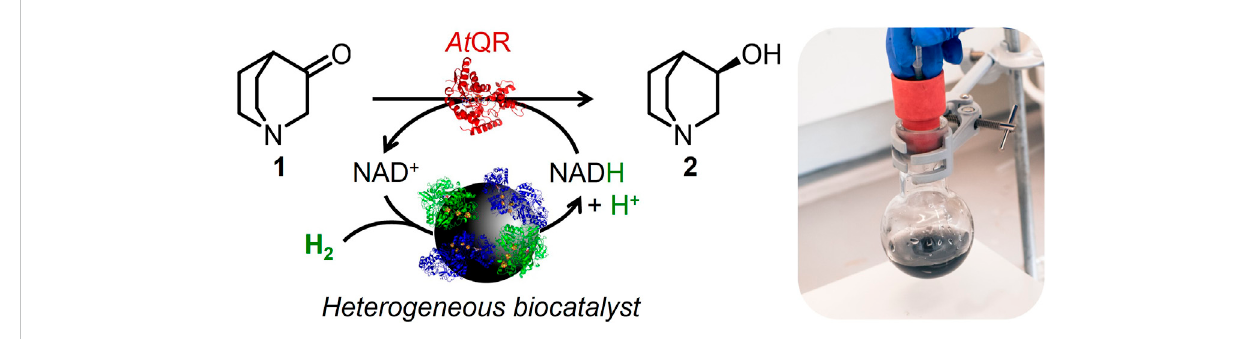
FIGURE 3 Heterogeneous biocatalytic hydrogenation of 1 in scale-down batch reactions. Photography credit: Charlie Flounders Photography © .